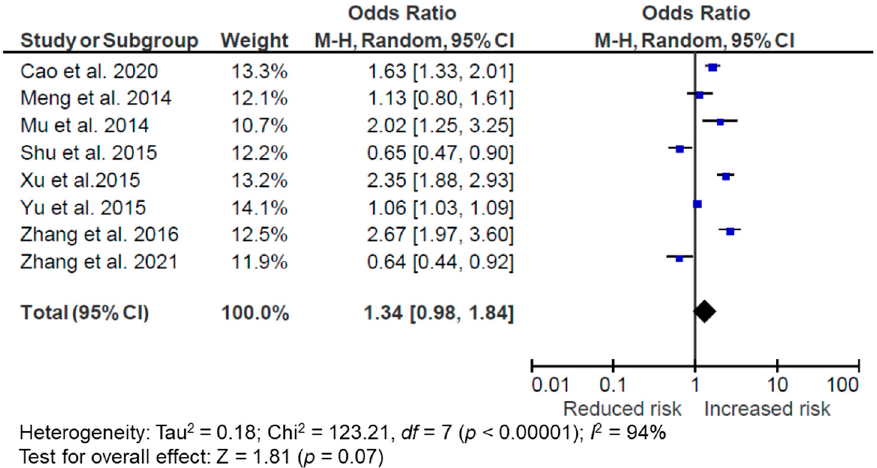
Figure 4. Forest plot of pooled odds ratios (ORs) with 95% confidence interval (CI) for the highest versus lowest quantile of the modern/Western dietary pattern for overweight/obesity [36,37,40,42,44,48,50,54].